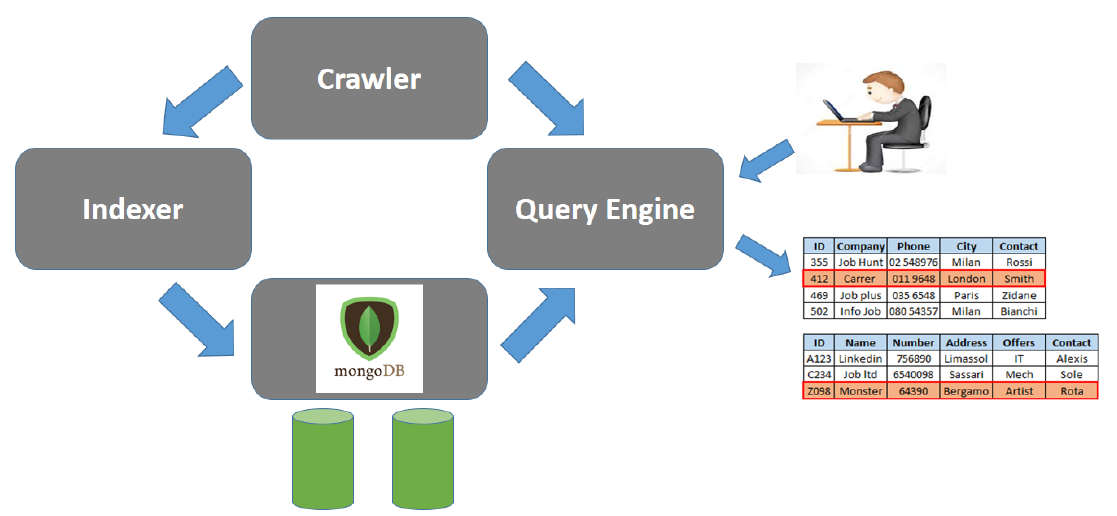
Figure 2. General architecture of the Hammer